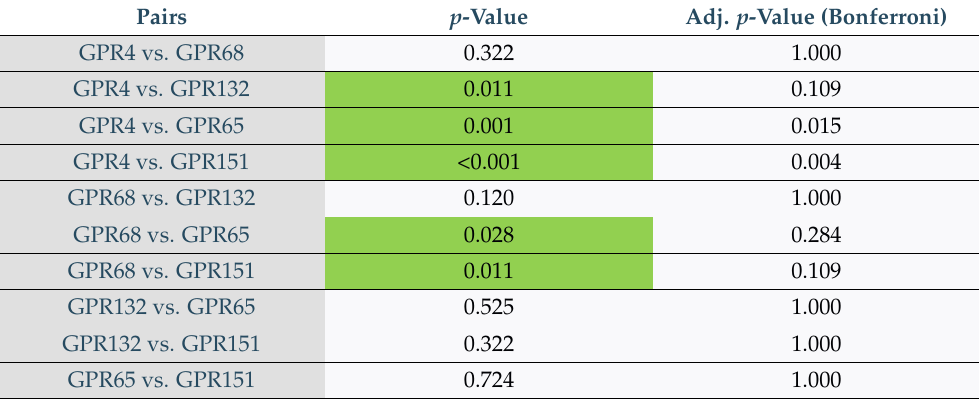
Table 2. Statistical analysis of GPR4, GPR65, GPR68, GPR132,